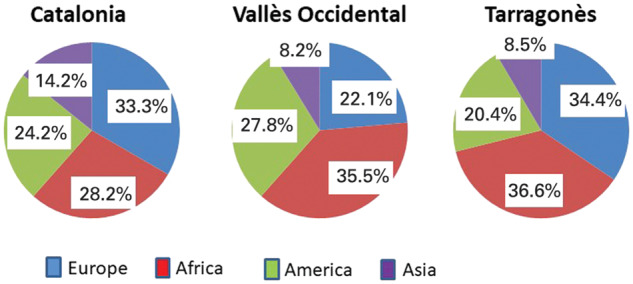
Origin of the immigrant population (Source: IDESCAT.CAT).